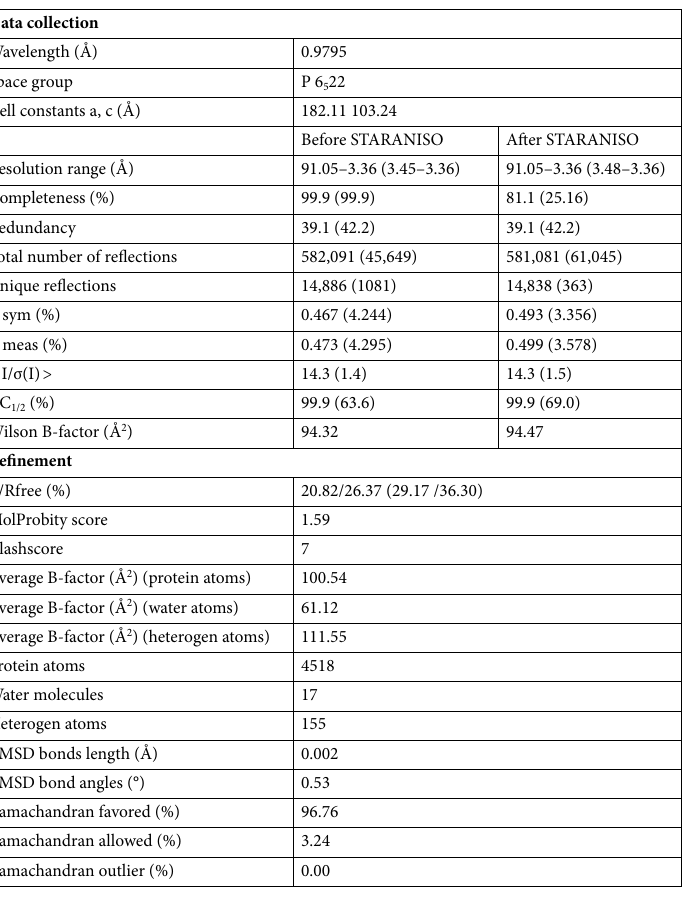
Table 2. Data collection and refinement statistics of the h COX-1 crystal structure (PDB code 6Y3C). Outer shell statistics are in parenthesis. For the sake of completeness, statistics before and after anisotropy correction by the STARANISO server are shown.